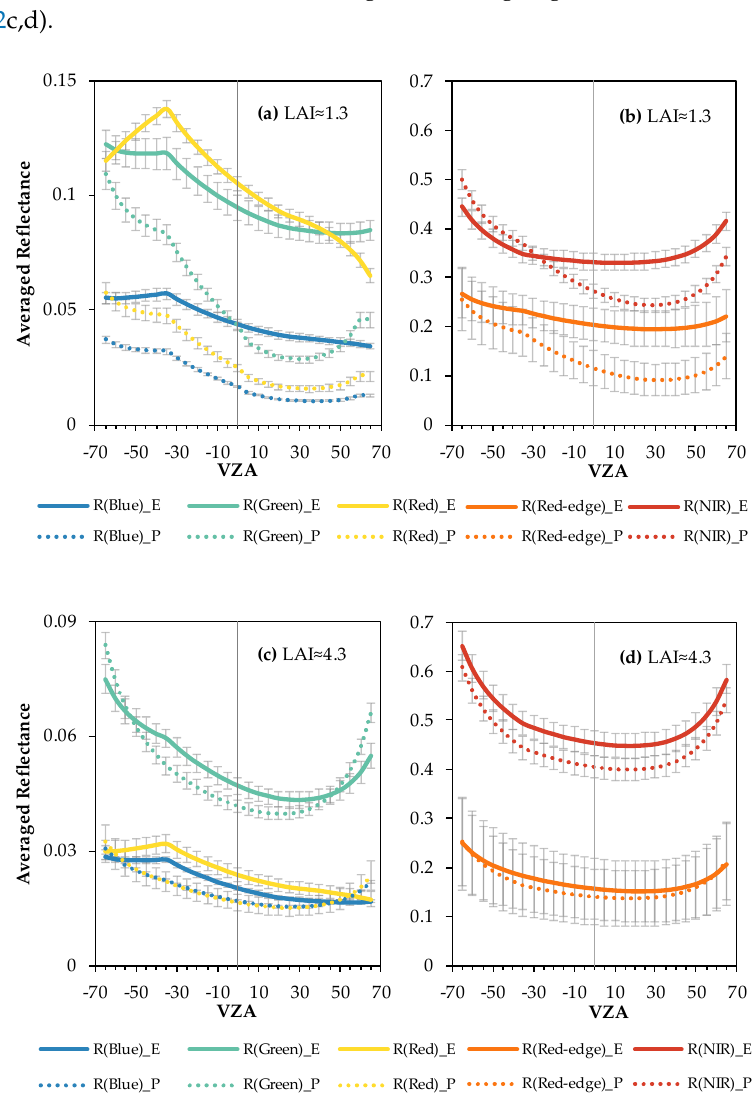
Figure 2. Average HDRFs of the red, blue, and green wavelengths for the erectophile (solid line, R(Red)_E, R(Blue)_E, R(Green)_E) and planophile varieties (dotted line, R(Red)_P, R(Blue)_P, R(Green)_P) in PP measured at ( a ) the returning green stage (LAI ≈ 1.3) and ( c ) heading stage (LAI ≈ 4.3) as well as the average hemispherical directional reflectance factors (HDRFs) of the red-edge, NIR wavelengths for the erectophile (solid line, R(Red-edge)_E, R(NIR)_E) and planophile varieties (dotted line, R(Red-edge)_P, R(NIR)_P) in PP measured at ( b ) returning green stage (LAI ≈ 1.3) and ( d ) heading stage (LAI ≈ 4.3). Standard deviation bars are indicated.